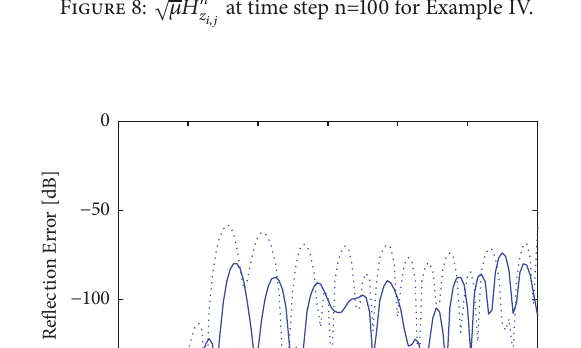
Figure 8: √𝜇𝐻 𝑛 𝑧 at time step n=100 for Example IV. 𝑖,𝑗